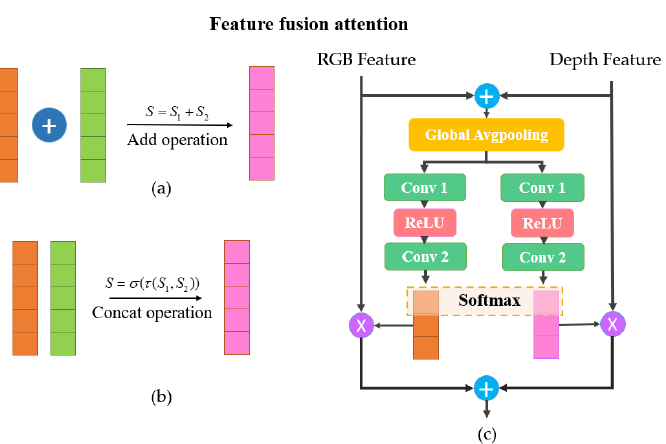
Figure 8. Schematic diagram of image feature fusion operation. ( a ) The schematic diagram of addition operation; ( b ) The schematic diagram of concat operation; ( c ) The schematic diagram of feature-fusion attention mechanism.